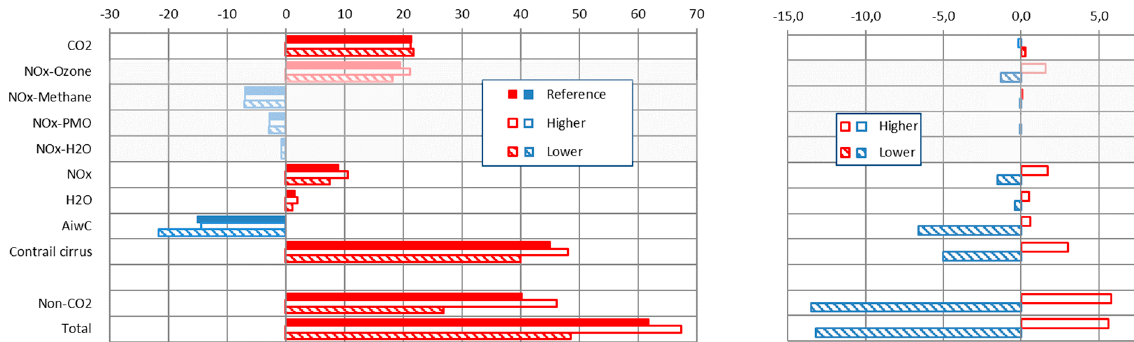
Figure 7. Global radiative forcing [mW/m 2 ] of aviation emissions for REACT4C scenarios: reference case (filled), Flying Higher (not filled) and Flying Lower (stripes) as absolute radiative forcings ( left ), and as changes for alternative flight altitudes scenarios compared to reference case ( right ).